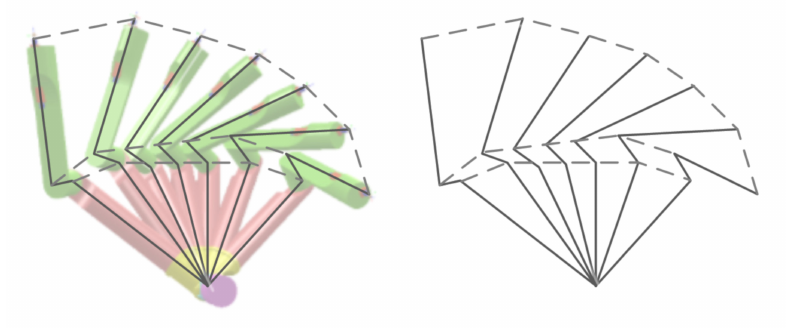
Figure 12. Schematic diagram of posture